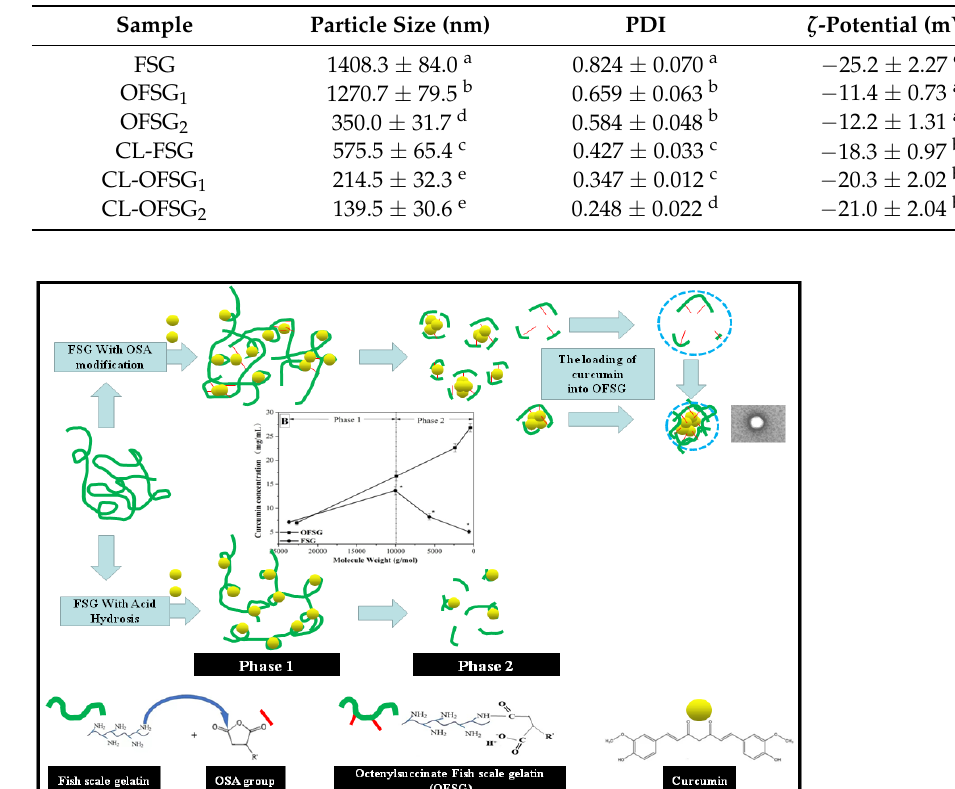
Figure 4. Schematic diagram illustrating the interactions between fish gelatin (FSG) with or without 2-octen-1-ylsuccinic anhydride (OSA) modification and curcumin. 2-octen-1-ylsuccinic anhydride (OSA) modification and